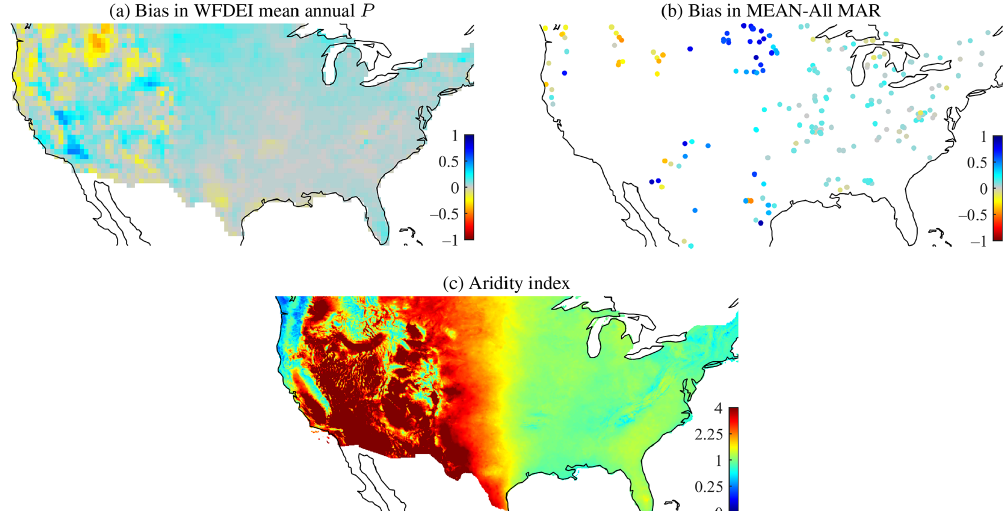
Figure 4. For the conterminous USA, (a) the bias in mean annual P from WFDEI relative to PRISM, (b) the bias in MAR from the MEAN- All ensemble relative to the observations, and (c) the aridity index, the ratio of mean annual PET (computed from PRISM air temperature using Hargreaves et al., 1985) to P (PRISM; note the nonlinear color scale). Each data point in (b) represents a catchment centroid. The bias in (a) and (b) was computed following B = (X − R)/(X + R) , where B is the bias, X the uncertain value, and R the reference value. B values range from − 1 to 1. A 100% overestimation results in B = 1 / 3, whereas a 50% underestimation results in B = − 1 / 3.